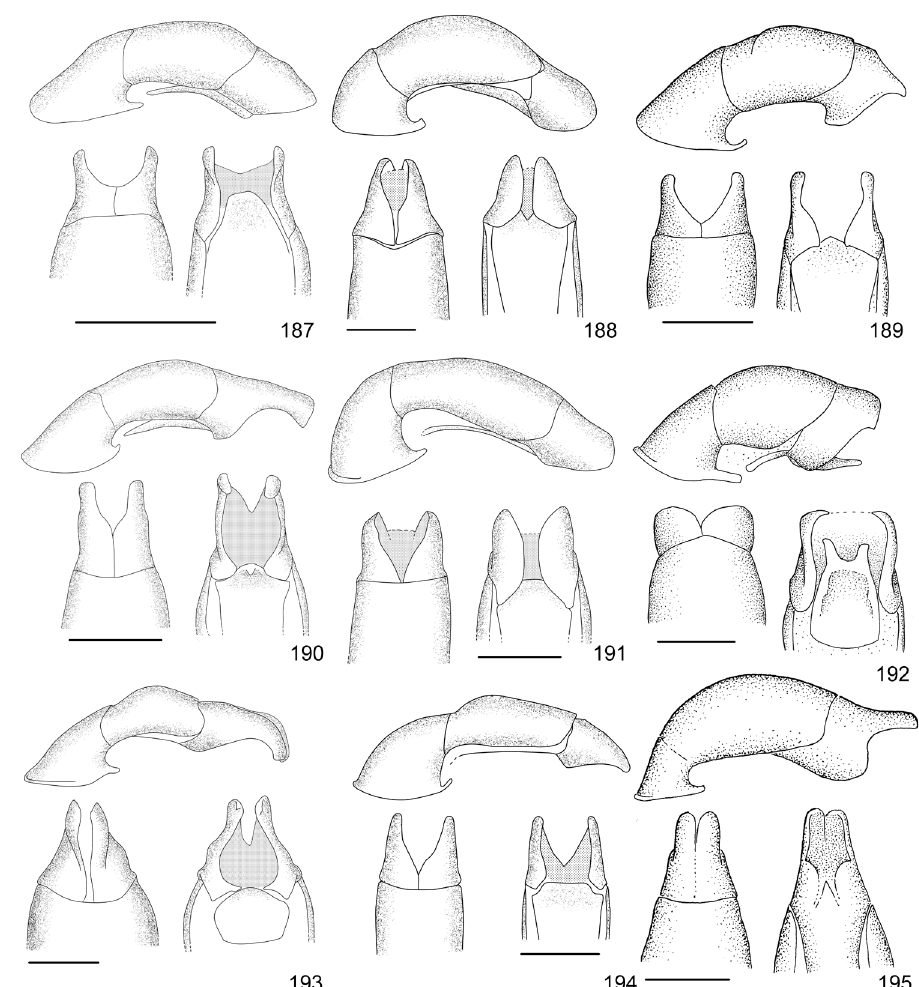
Figures 187–195. Shape of aedeagus, lateral view (top), dorsal view (bottom left), ventral view (bottom right). 187 Anomala unilineata (Parque Nacional Santa Rosa, Guanacaste, MNCR) 188 A. valida (La Cruz, Guanacaste, MNCR) 189 A. vallisneria (Sector Las Pailas, Guanacaste, MNCR) 190 A. veraecrucis (Finca Jenny, Guanacaste, MNCR) 191 A. volsellata (Las Quebraditas, Puntarenas, MNCR) 192 A. vulcanicola (San Gerardo de Dota, San José, MNCR) 193 A. zumbadoi (Rancho quemado, Puntarenas, MNCR) 194 Anomalorhina turrialbana (Cabanga, Alajuela, CEUA) 195 Callistethus calonotus (Alto de Las Moras, Puntarenas, MNCR). Scale bars: 1 mm. Figs 191, 193 from Filippini et al. (2014); Fig. 195 modified from Filippini et al. (2015a); Fig. 187 from Filippini et al. (2015c); Figs 189, 192 from Filip- pini et al.